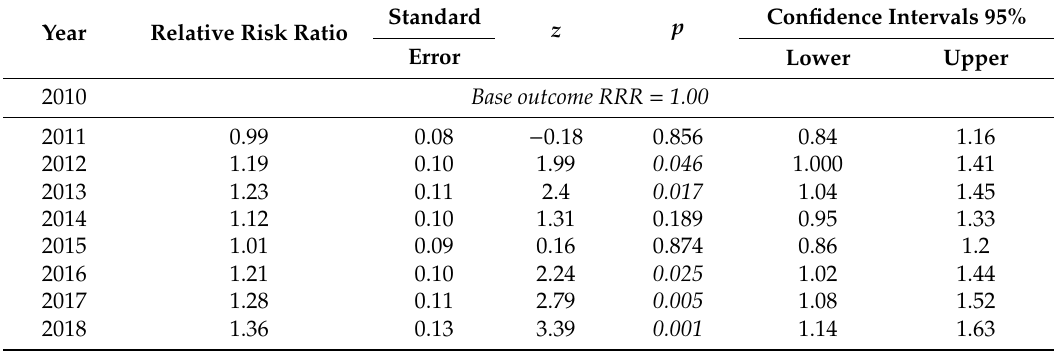
Table 1. Relative risk ratio of death in hospital environment due to asthma in Mexico between 2010 and 2018. Year Relative Risk Ratio